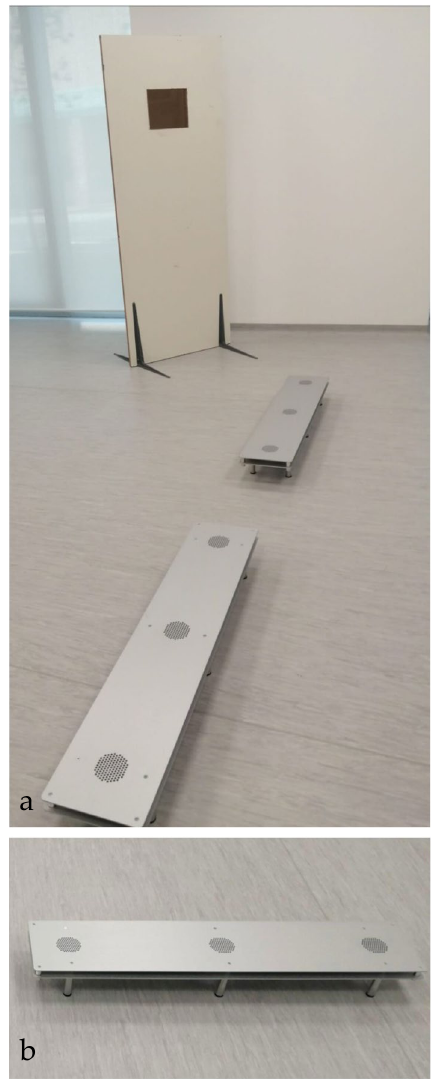
Figure 1. ( a ) The two especially designed stainless steel and aluminium apparatuses positioned in a single straight line on the floor, spaced 40 cm apart; ( b ) detail of the